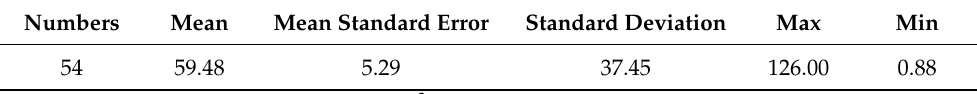
Table 2. Statistical information of AGB in plots.